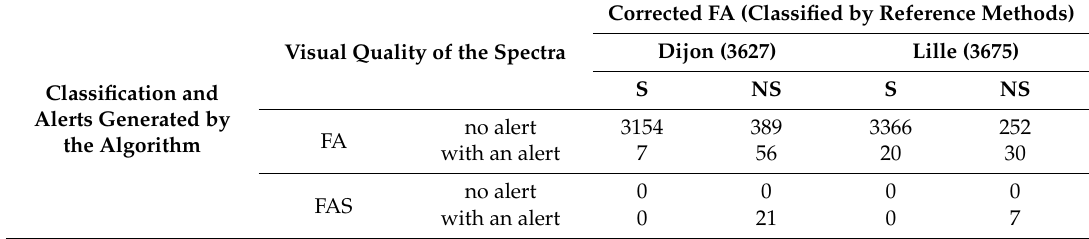
Table 2. Frequency of alert set 2 for FA samples at each analytical